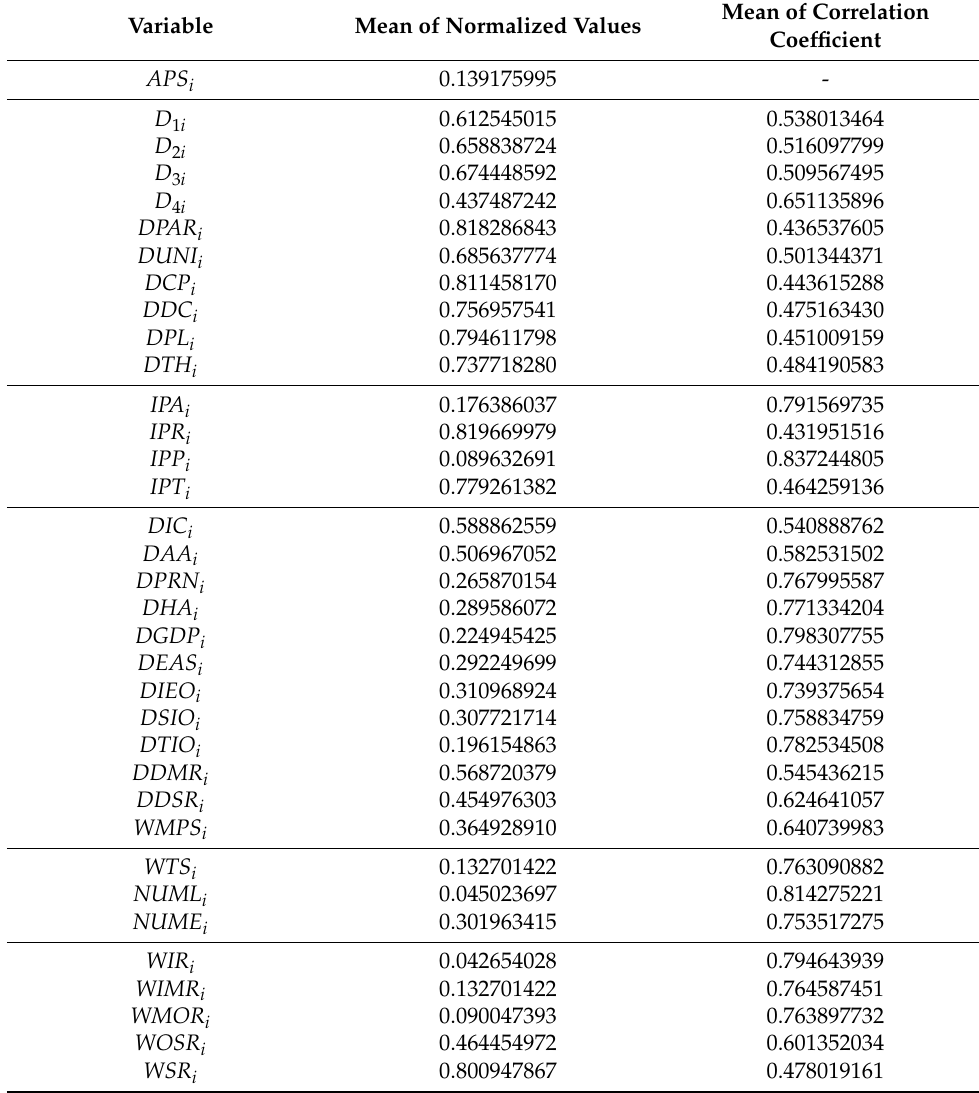
Table 2. Standardization and average correlation coefficients between passenger flow of stations and five types of influencing